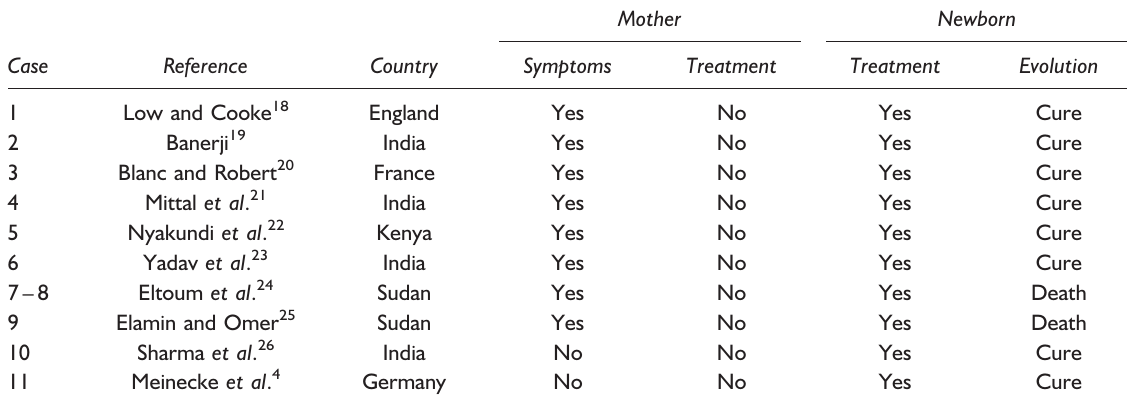
Table 1 Cases of congenital visceral leishmaniasis according to year of publication, country of origin, clinical manifestations, maternal treatment and the treatment and evolution of the